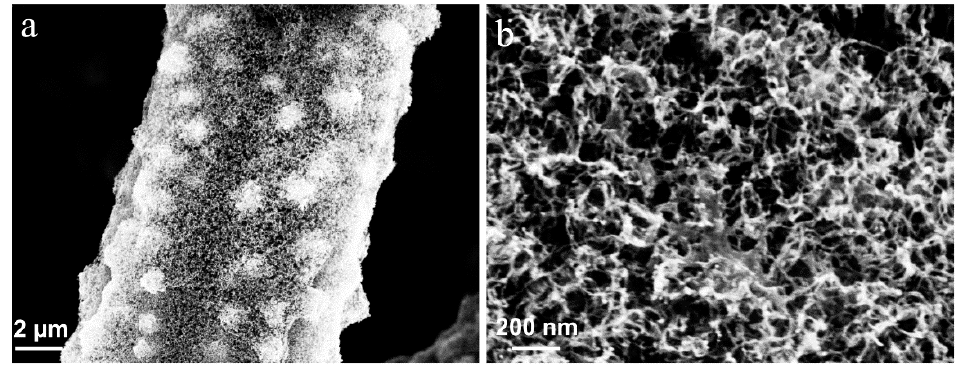
Figure A1. ( a , b ) SEM images of Co-FeS 2 / CoS 2